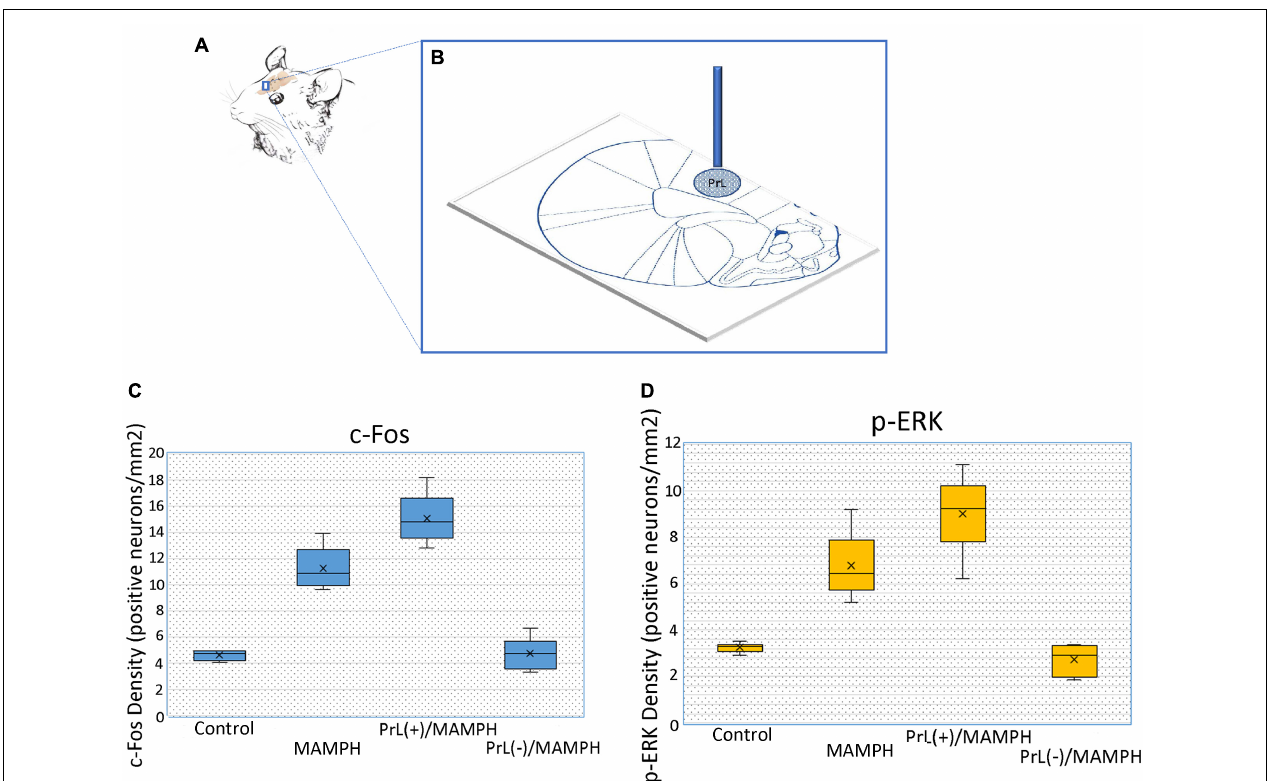
FIGURE 1 | (A) The rat’s brain atlas showing the PrL location as a small vertical bar. (B) The location of the PrL microinjection. The blue vertical bar represents the buried cannula placement. The spot area indicates the distributions of saline or the NMDA microinjections. The density of (C) c-Fos or (D) p-ERK in positive neurons/mm 2 in the PrL for the control, MAMPH, PrL (+)/MAMPH, and PrL(–)/MAMPH